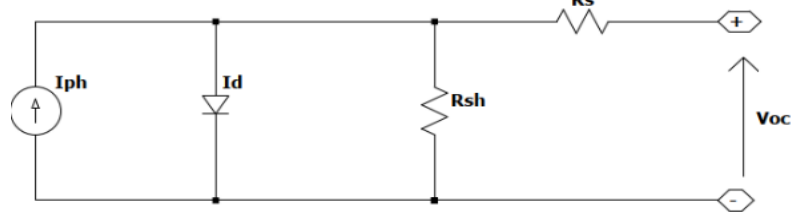
Figure 2. Electrical model equivalent to a diode of a solar cell